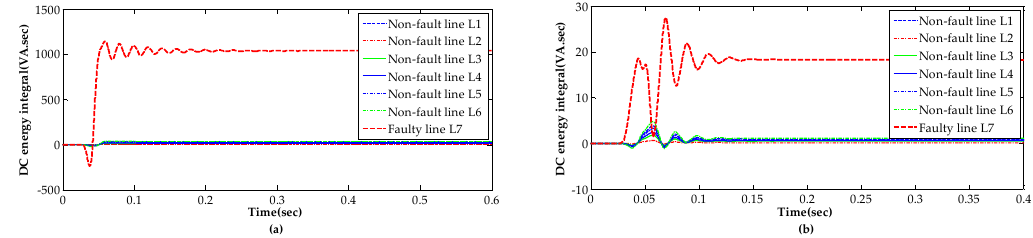
Figure 11. Results under SPG faults occurring on the longer line L 7 at 7 km away from the bus, at different initial phase angles and resistances. ( a ) =0 ,